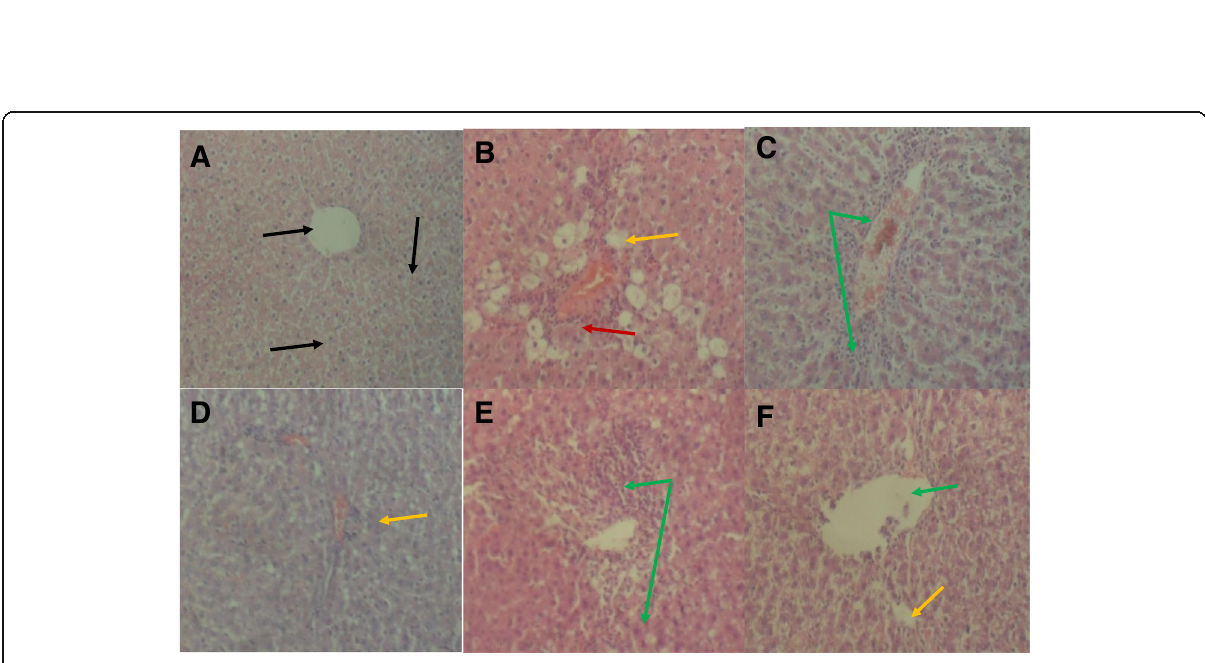
Fig. 10 Photomicrographs of liver sections from a Control rats showing normal liver histology: Black arrow heads indicate normal central vein, hepatocytes, sinusoids b rats intoxicated with CCl 4 on the 8th day c rats treated with 250 mg/kg bw.TC for 7 days, thereafter intoxicated with CCl 4 on the 8th day d rats treated with 500 mg/kg bw.TC seed for 7 days,thereafter intoxicated with CCl 4 on the 8th day e rats intoxicated with CCl 4 and then given methanol extract of TC seed (250 mg/kg body weight orally) at 1 h, 6 h, 12 h, 18 h and 24 h f rats intoxicated with CCl 4 and then given methanol extract of TC seed (500 mg/kg body weight orally) at 1 h, 6 h, 12 h, 18 h and 24 h. The liver sections were stained with H/E and observed with a 10 X objective. Arrow heads (Orange): Vesicular steatosis/fatty accumulation; (Dark Red): Extensive hemorrhagic necrosis; (Green): Mild/patchyportal hepatitis. TC: Tetracarpidium conophorum